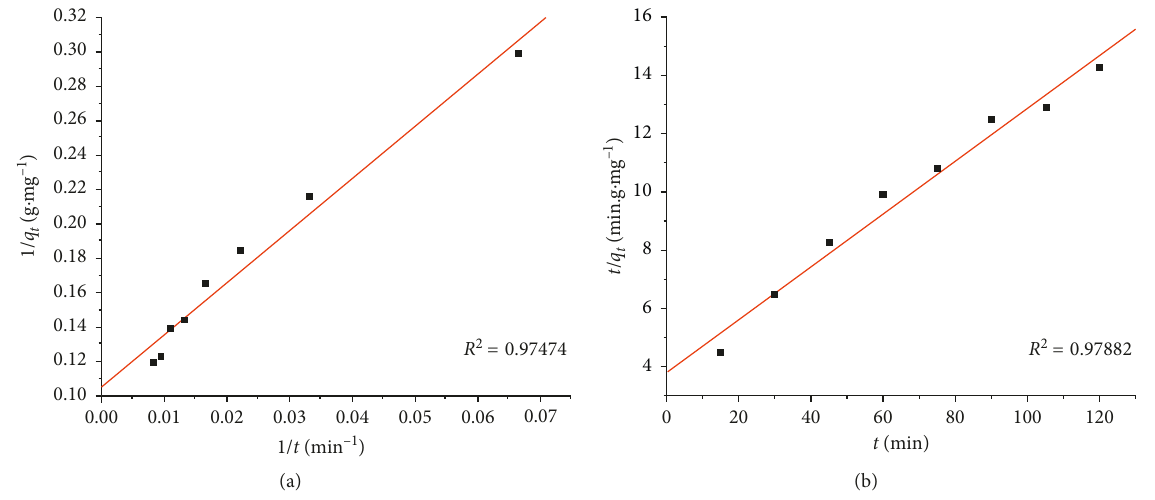
Figure 7: (a) First-order kinetics; (b) pseudo-second-order